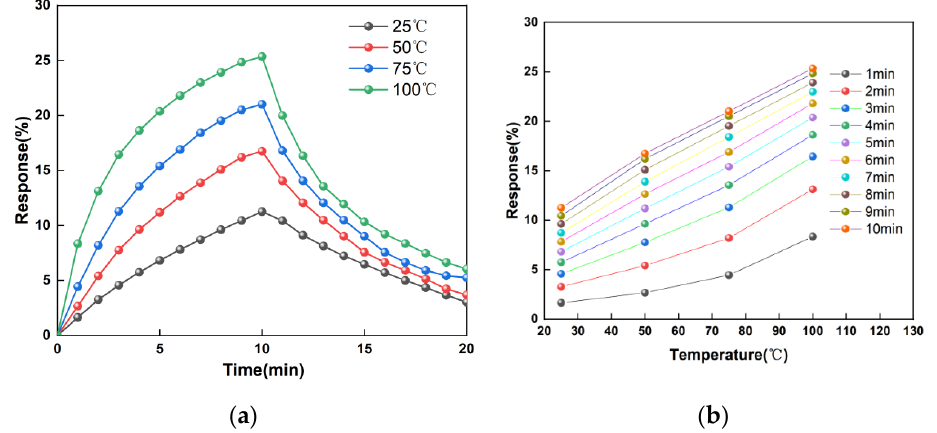
Figure 8. The temperature response of the sensor. ( a ) The response of the sensor with time. ( b ) The response of the sensors with different temperature.